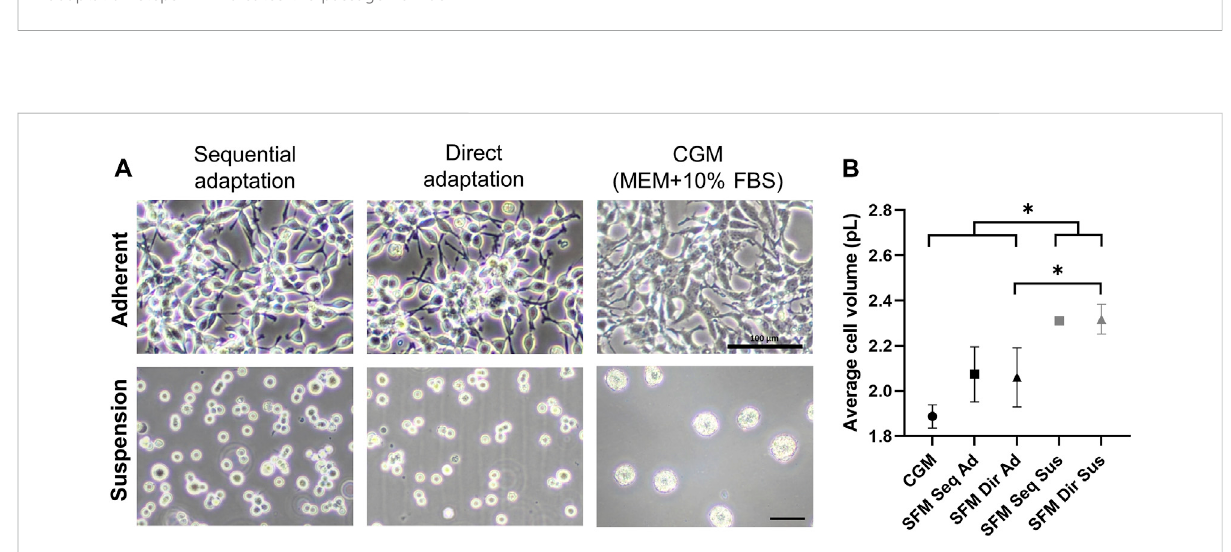
FIGURE 3 (A) Bright- fi eld images of adherent and suspension HEK293 cells after completing serum-free medium cultures. Scale bars indicate 100um. (B) Cell volumes were measured on the second day in 5 different cultures. * indicates a signi fi cant difference between the groups ( p < 0.05) after Tukey multiple comparisons test. (CGM; control growth medium culture , SFM Seq Ad; Serum-free medium sequential adapted adherent culture, SFM Dir Ad: Serum-free medium direct adapted adherent culture, SFM Seq Sus; Serum-free medium sequential adapted suspension culture, SFM Dir Sus; Serum-free medium direct adapted suspension